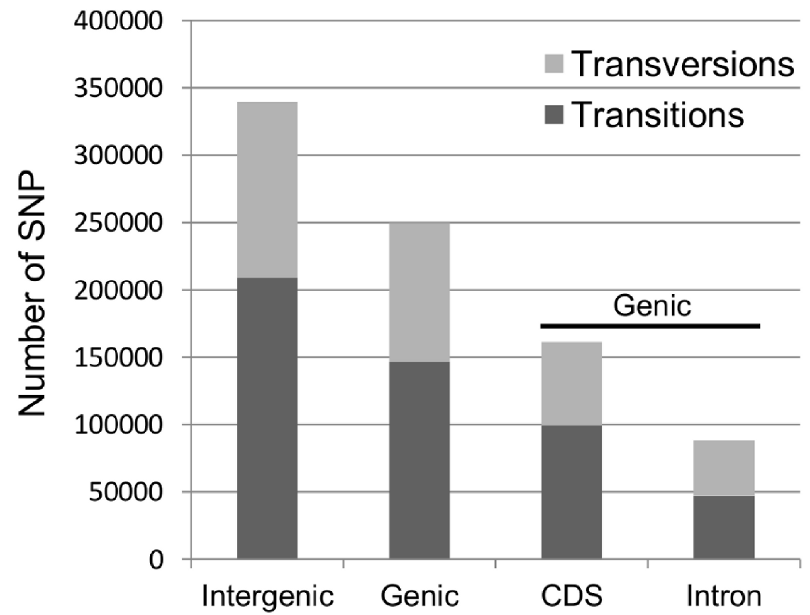
Figure 3. Filtered SNP counts characterization summary. Total SNP counts were classified by genomic location (Intergenic vs. Genic) and further separated into transitions and transversions. Genic SNPs are also described in terms of their location within the gene (CDS vs. intron). CDS: coding